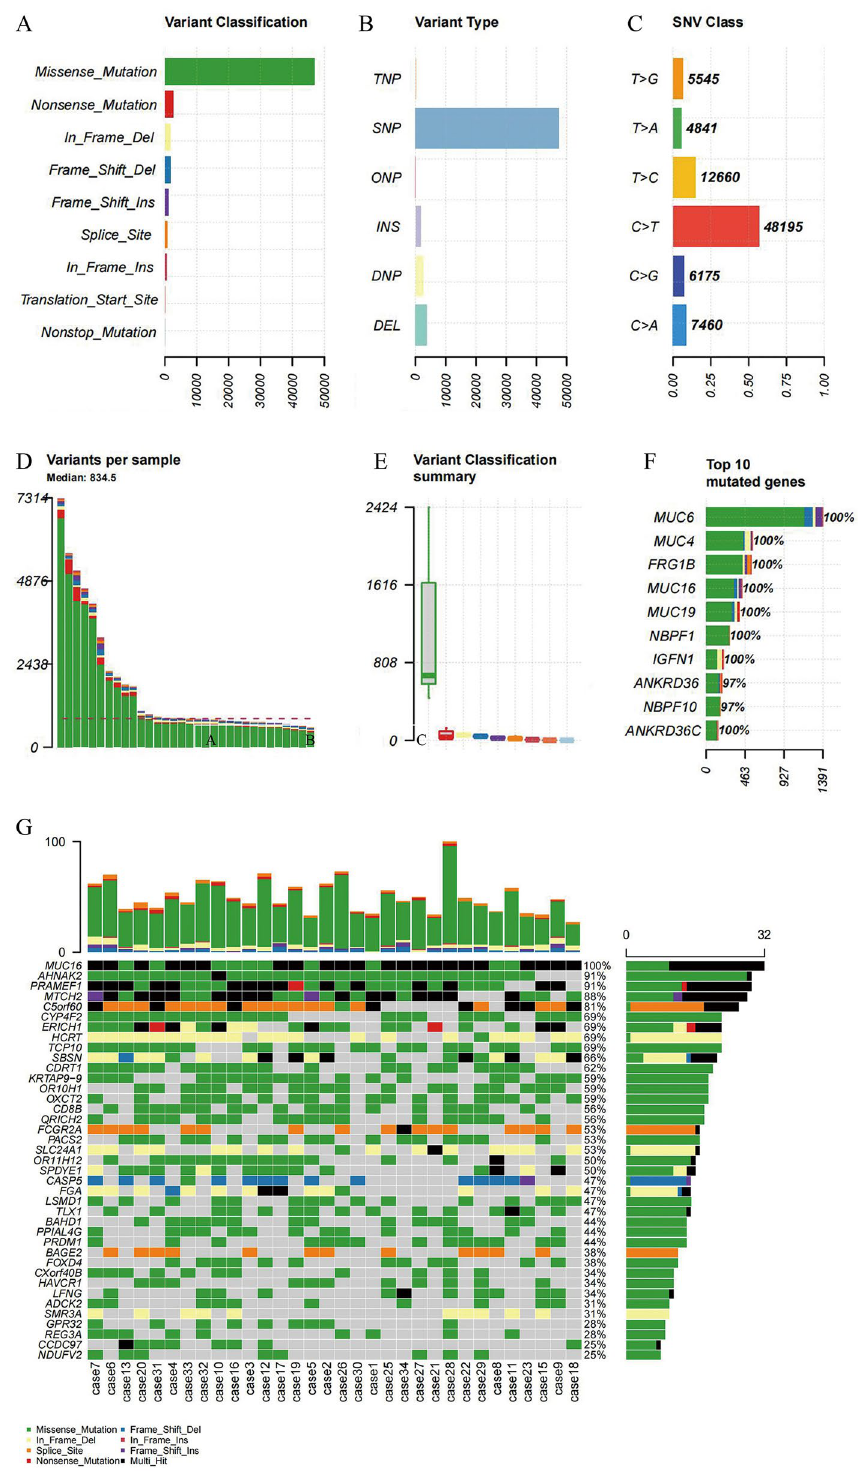
Figure 1. Somatic mutation analysis. ( A ) Variant classification, x represents quantity, y represents classification ( B ) Variant types, x represents quantity, y represents type ( C ) SNV classification, x represents ratio, y represents class ( D ) number of variants in each sample ( E ) Box plot of variant types, x represents quantity, y represents classification ( F ) quantity and frequency of the top10 mutated genes ( G ) Map of high-frequency variant genes. top: quantity of variant types in each sample, x represents sample, y represents the number of variants; bottom: types of genetic variants in different samples, x represents a sample, y represents a gene’s name; right: frequency of genetic variants in different samples. x represents frequency of each gene in a sample, and y represents gene’s